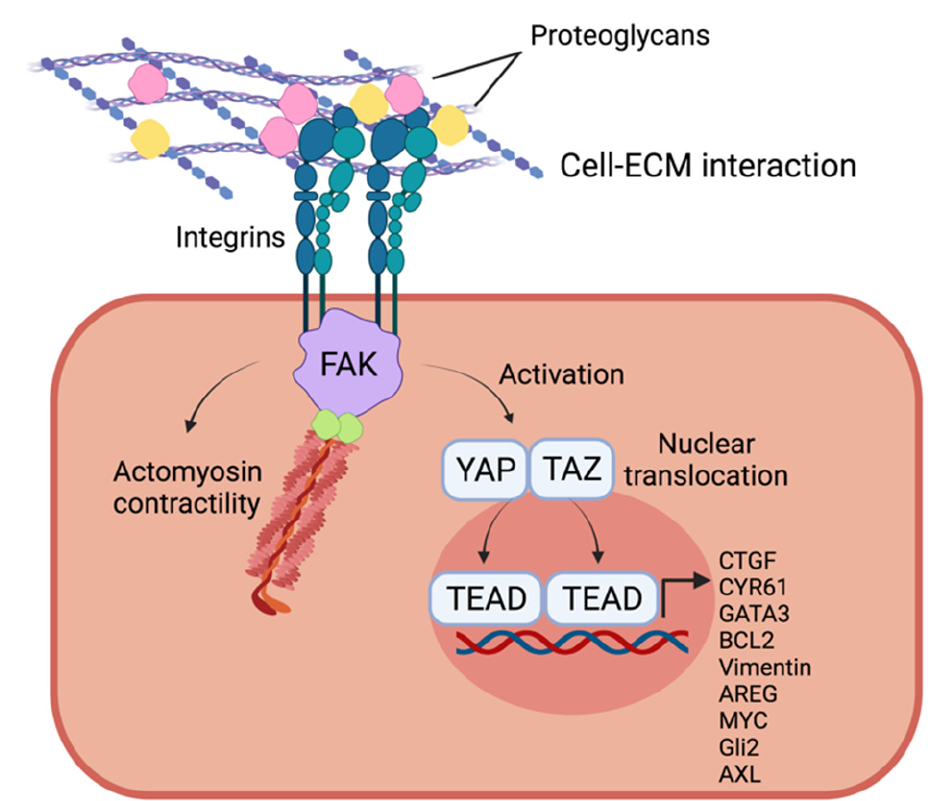
Figure 3. PDAC cell response to stiffness and solid stress. The interaction between ECM and PDAC cells occurs through the binding to adhesion proteins, such as integrins, expressed on the cell surface, and it is further stabilized by proteoglycans. This interaction triggers the actomyosin contractility and the activation of YAP/TAZ, which translocate to the nucleus to induce gene transcription. EMT is triggered by the accumulation of YAP and the transcriptional coactivator with the PDZ-binding motif, also known as WWTR1 (TAZ), within the nuclei [119–123]. YAP and TAZ need DNA-binding partners, as YAP and TAZ have no DNA binding ability. So, according to the partner, they can induce the expression of a wide range of genes, both tumorigenic and tumor suppressors [124]. However, when cell–cell adhesions decrease, the nuclear activated YAP/TAZ bind to TEAD, which is a transcriptional factor, accomplishing the expression of target genes: CTGF, CYR61, GATA3, BCL2, Vimentin, AREG, MYC, Gli2 and AXL. These are all genes involved in cell migration, proliferation, cell–ECM adhesion, ECM remodeling, anti-apoptotic mechanisms and cell stemness [124,125]. At this step, cells show less protein designated to maintain cell–cell interactions such as E-cadherin, causing a loss of tissue polarity, while they increase the expression of vimentin, which is a marker of mesenchymal cells [68,121]. YAP/TAZ nuclear translocation can be similarly induced by the interaction of laminin 5 to α 6 β 4, allowing the tumor cells to maintain their stemness, as shown in epidermal stem cells [126]. Additionally, integrin β 1 has been demonstrated to be involved in inducing the activation of ECM-bound TGF- β through mechanical processes. Normally, the latent TGF- β binding protein (LTBP) retains inactive TGF- β 1 proteins bound to ECM. During the remodeling and stiffening of the ECM, the integrin β 1 of pancreatic stellate cells (PSCs) induces the release and activation of TGF- β . This process is induced by the tension caused upon the activation of the actomyosin system [88,127]. Through mechanosensor machinery, PDAC cells have the ability to migrate and invade stiffer substrates, which is called durotaxis. Regarding this, activated PSCs have been shown to migrate according to substrate rigidity by means of integrin β 1 [128].